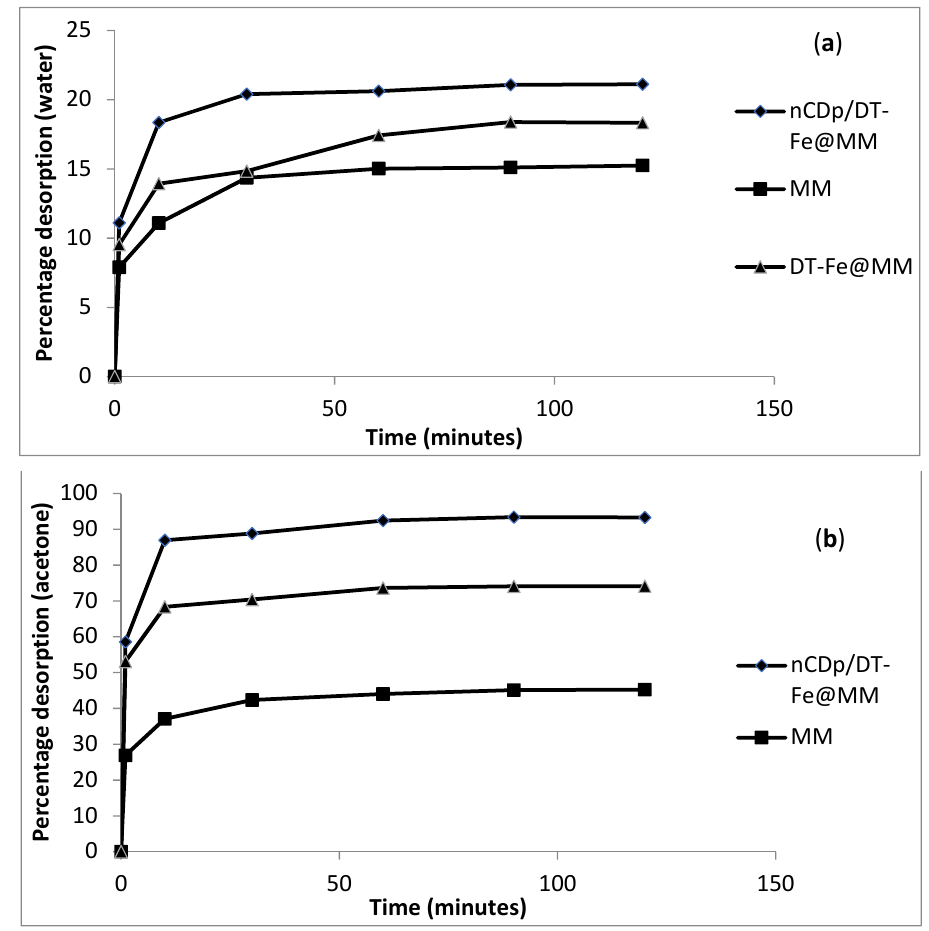
Figure 15. ( a , b ) Rate of desorption of BPA from used adsorbent residue using DI water and acetone. (Desorption conditions: volume of DI water; 40 mL; dosage = 0.02 g/L; t = 1–120 min; pH = 8).